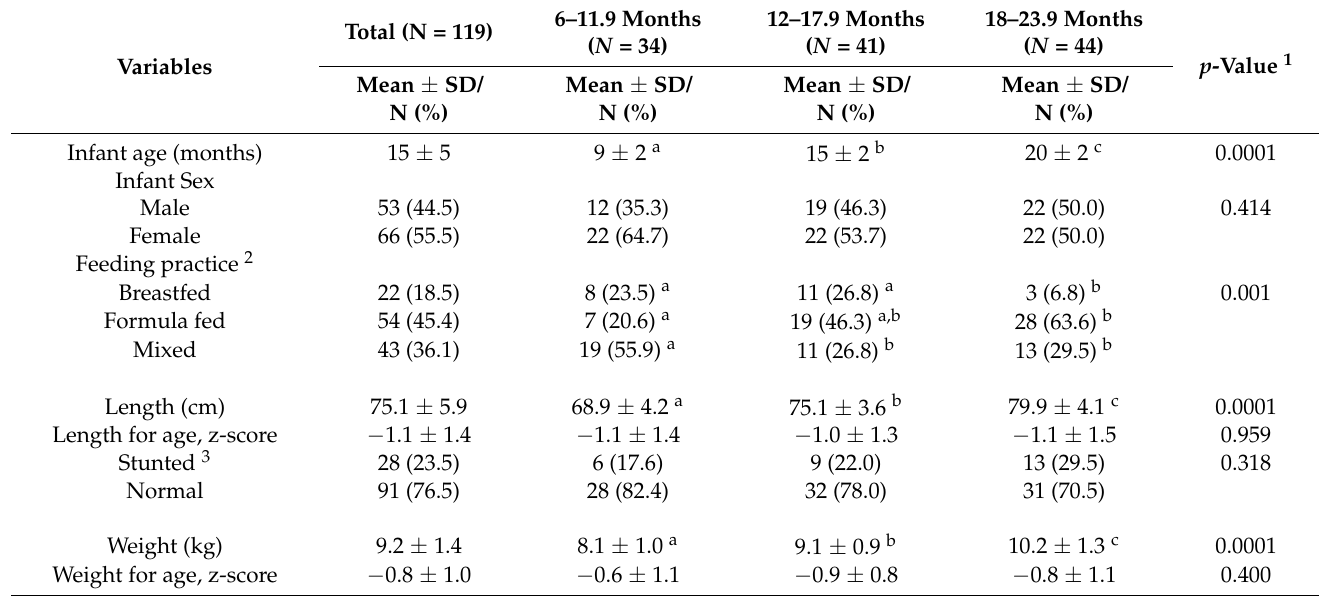
Table 1. Nutritional and feeding status of